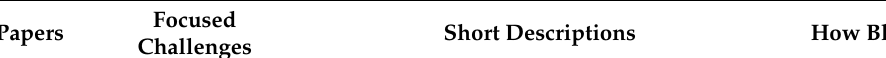
Table 2. Resource Scheduling Related